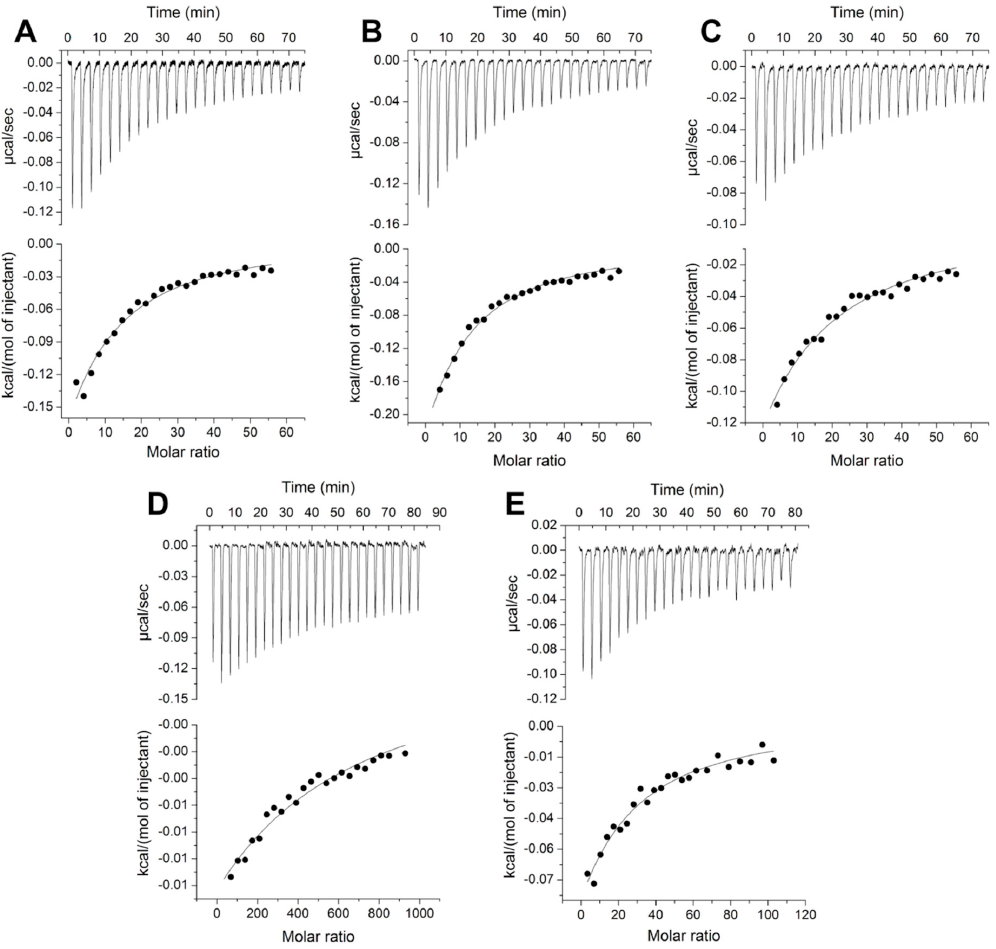
Figure 3. ITC titrations of Tlp3 LBD (10 μ M) with ( A ) 4-methyl-L-isoleucine (3 mM), ( B ) β -methyl-L- norleucine (3 mM), ( C ) 3-methyl-L-isoleucine (3 mM), ( D ) L-alanine (50 mM), and ( E ) L-phenylalanine (5 mM). The solid line represents the least-squares fit of the experimental data to a single-site binding mode.